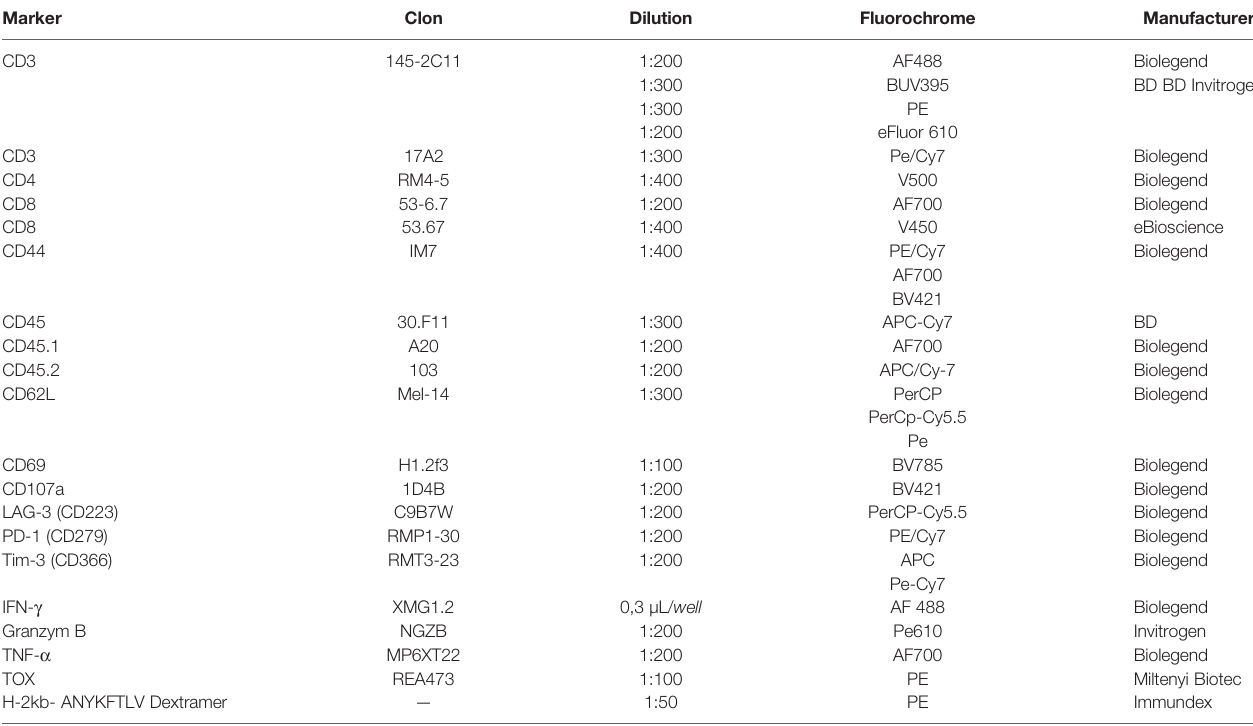
TABLE 1 | List of used antibodies.